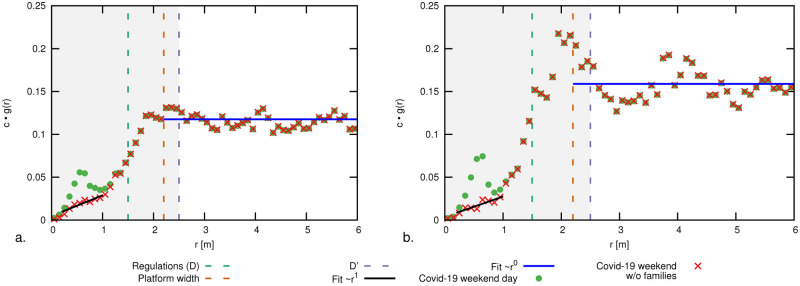
Radial distribution functions (RDF), g(r), for a typical weekend day in case of (a) 40-50 pedestrians on the platform, (green domain in Fig 2) and (b) 70-80 pedestrians on the platform (purple domain in Fig 2). The same conventions of Fig 2 hold. The presence of family-groups determine a peak in the RDFs around r ≈ 0.5m, which is much more pronounced than in the working day case. Discounting these contributions via the graph analysis notably restores a ∼r1 growth rate at small r values.